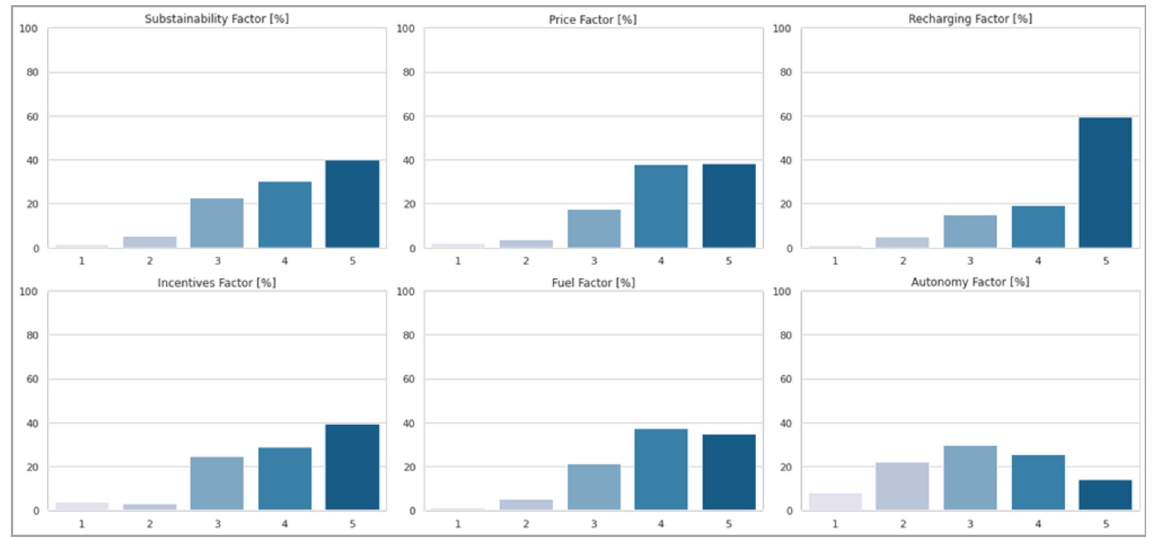
Fig 11. Respondents’ opinion towards the main factors influencing the spread of electric cars. They had to assign a weight from 1 to 5 to each of the factors.